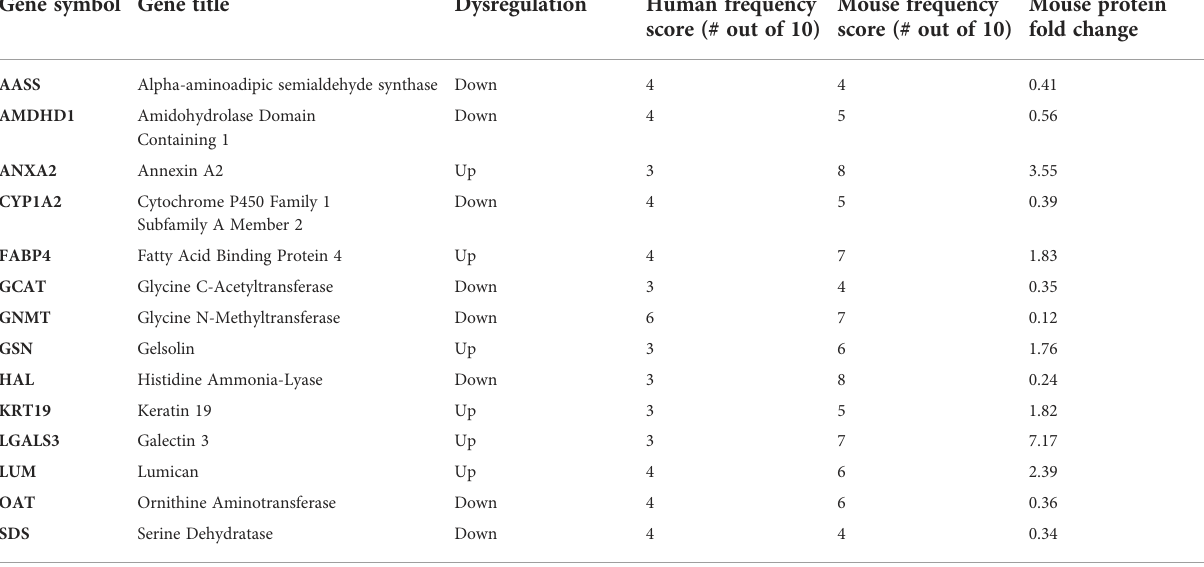
TABLE 3 List of 14 common NASH signatures validated at the protein expression level.